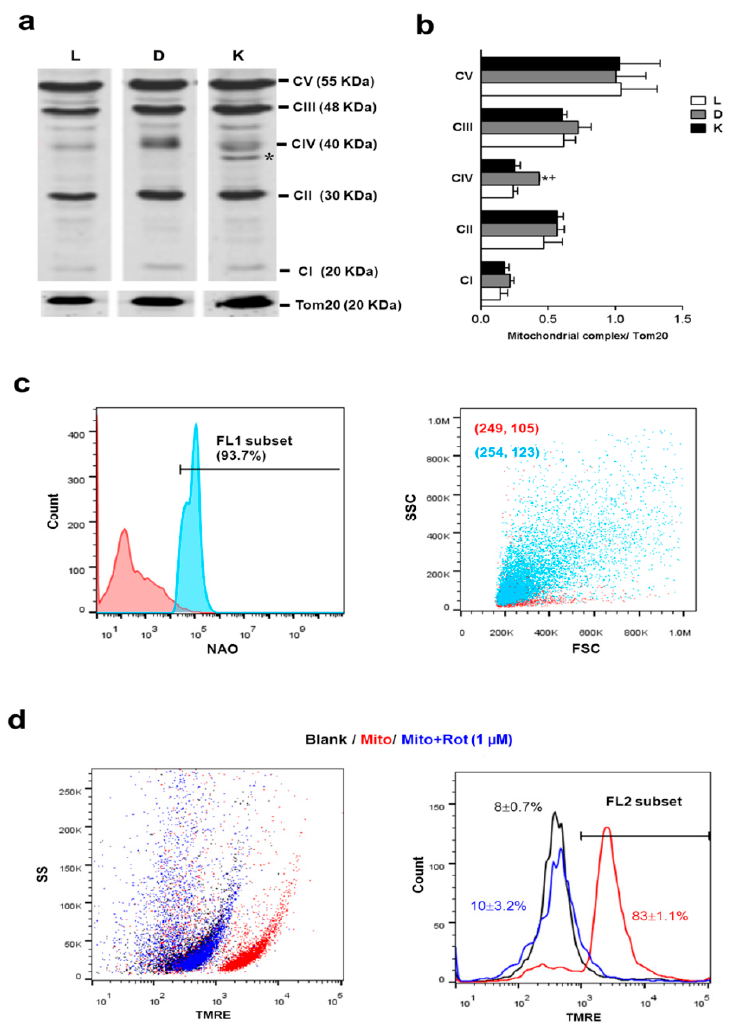
Figure 5. Comprehensive measurement of isolated mitochondrial function via different extracted methods. ( a ) The performance of mitochondrial complex I-V proteins (CI-CV) was analyzed and ( b ) quantified by normalizing the mitochondrial amount presented by the mitochondrial marker protein of Tom20. * p < 0.05, significant difference to compare with L group. + p < 0.05, significant difference to compare with K group.( c ) Purity of device-extracted mitochondria was analyzed by flow cytometry using 10- N -nonyl acridine orange (NAO) dye for specifically label mitochondria in the inner membrane. Population NAO-positive signals (bluish histogram) was gating by adjusting the autofluorescence of mitochondria without staining (blank group, reddish histogram, left panel). ( c ) The dot plot of the forward scatter/side scatter (FSC/SSC) showed the difference in particle size and granularity between mitochondrial (bluish dot plot) and non-mitochondrial populations (red dot plot) (right panel). ( d ) Tetramethylrhodamine ethyl ester (TMRE), mitochondrial membrane-dependent dye, was conducted to measure activity of device-extracted mitochondria with mitochondrial inhibitor rotenone (Rot) (Mito+Rot group, blue dot plot and histogram) treatment for 30 min by flow cytometry or not (Mito group, red dot plot and histogram) (left panel). The population of active mitochondria in each group was quantified by gating autofluorescence of mitochondria without staining (blank group, dark dot plot and histogram) (right panel). L: total cell lysis, D: microfluidic device, K: commercially available mitochondria isolation